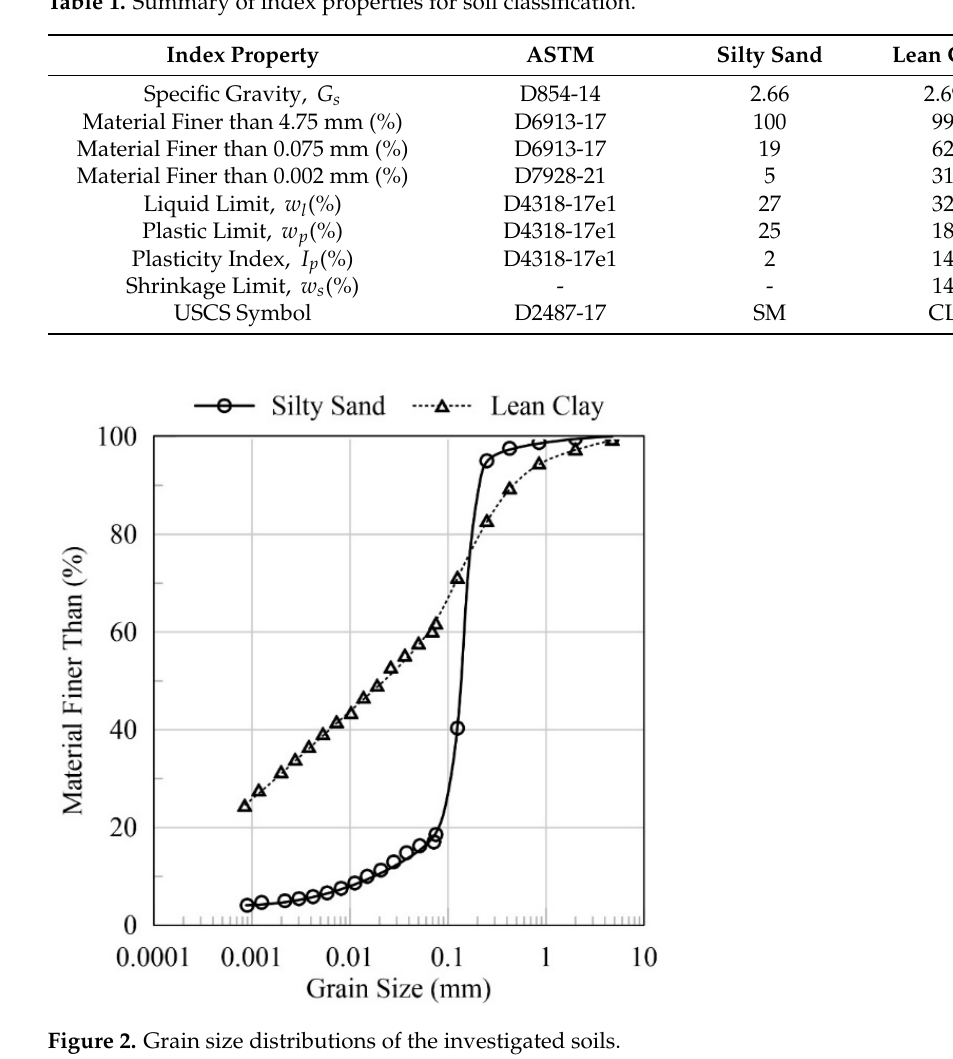
Table 2. Summary of initial conditions of soil samples.